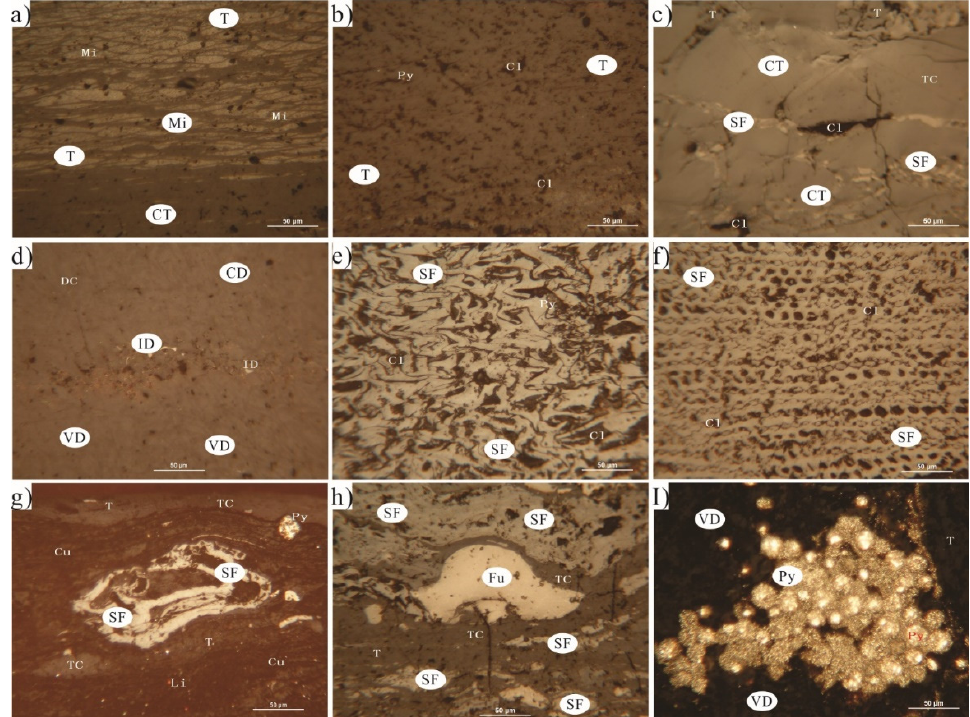
Figure 3. Photomicrographs of vitrinite and inertinite, polished surface, oil immersion, and